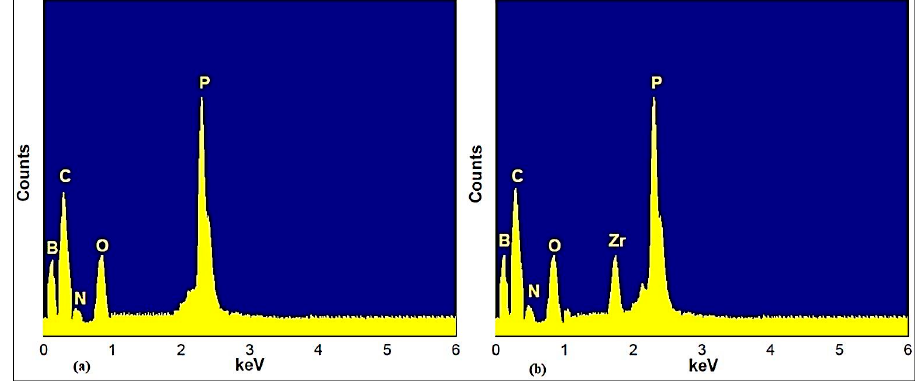
Figure 14. EDS spectra of the flame retardant char samples ( a ) F0 and ( b ) F3.